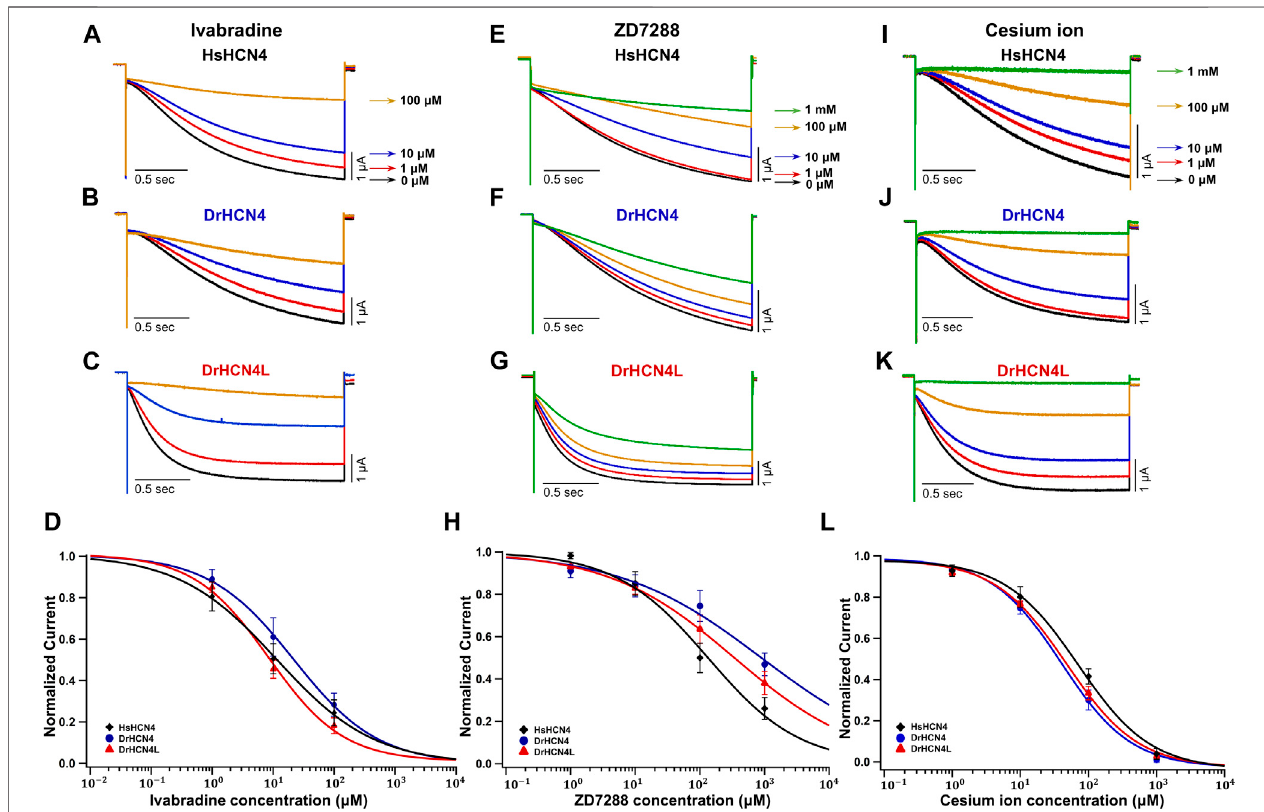
FIGURE 4 | Sensitivities of DrHCN4 and DrHCN4L to HCN inhibitors. (A – C) Representative current traces sequentially applied with 0 – 100 µM of ivabradine. The holding potential was − 30 mV and was hyperpolarized to − 120 mV for 2 s. (D) Ivabradine inhibition curves based on currents of (A – C) . DrHCN4 (blue; n = 5), DrHCN4L (red; n =4)andHsHCN4(black; n =4). (E – G) Representativecurrenttracessequentiallyappliedwith0 μ M – 1 mMofZD7288.Theholdingpotentialwas − 30 mVandwas hyperpolarized to − 120 mV for 2 s. (H) ZD7288inhibition curvesbased oncurrentsof (E – G) . DrHCN4(blue; n = 5), DrHCN4L (red; n = 5)and HsHCN4(black; n = 5). (I – K) Representativecurrentssequentiallyappliedwith0 μ M – 1 mMofcesiumion.Theholdingpotentialwas − 30 mVandwashyperpolarizedto − 120 mVfor2 s. (L) Cesium ion inhibition curves based on currents of (I – K) . DrHCN4 (blue; n = 5), DrHCN4L (red; n = 5) and HsHCN4 (black; n = 5).